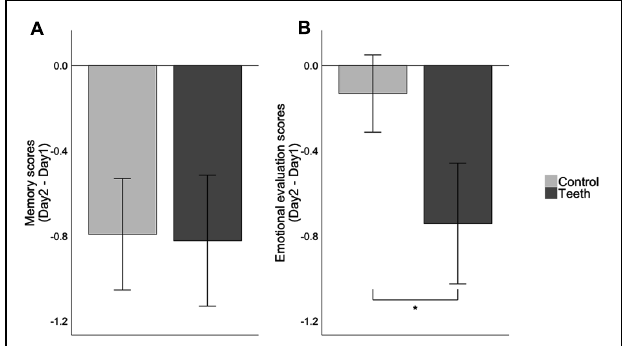
FIGURE 2 | Differential scores for memory and emotional evaluation. Differential scores were calculated by subtracting day 2 scores to day 1 scores. Scores equal to 0 mean no difference across sessions and negative scores indicate a decrease from session 1 to session 2. (A) Differential scores for the memory of the text. (B) Differential scores of emotional evaluation of the text. Notes: error-bars are SEM, ∗ p <